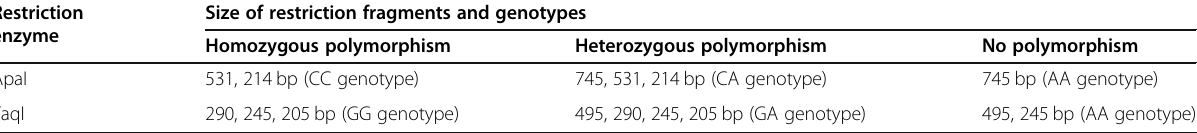
Table 1 Size of DNA fragments following digestion with ApaI and TaqI restriction enzymes Restriction enzyme